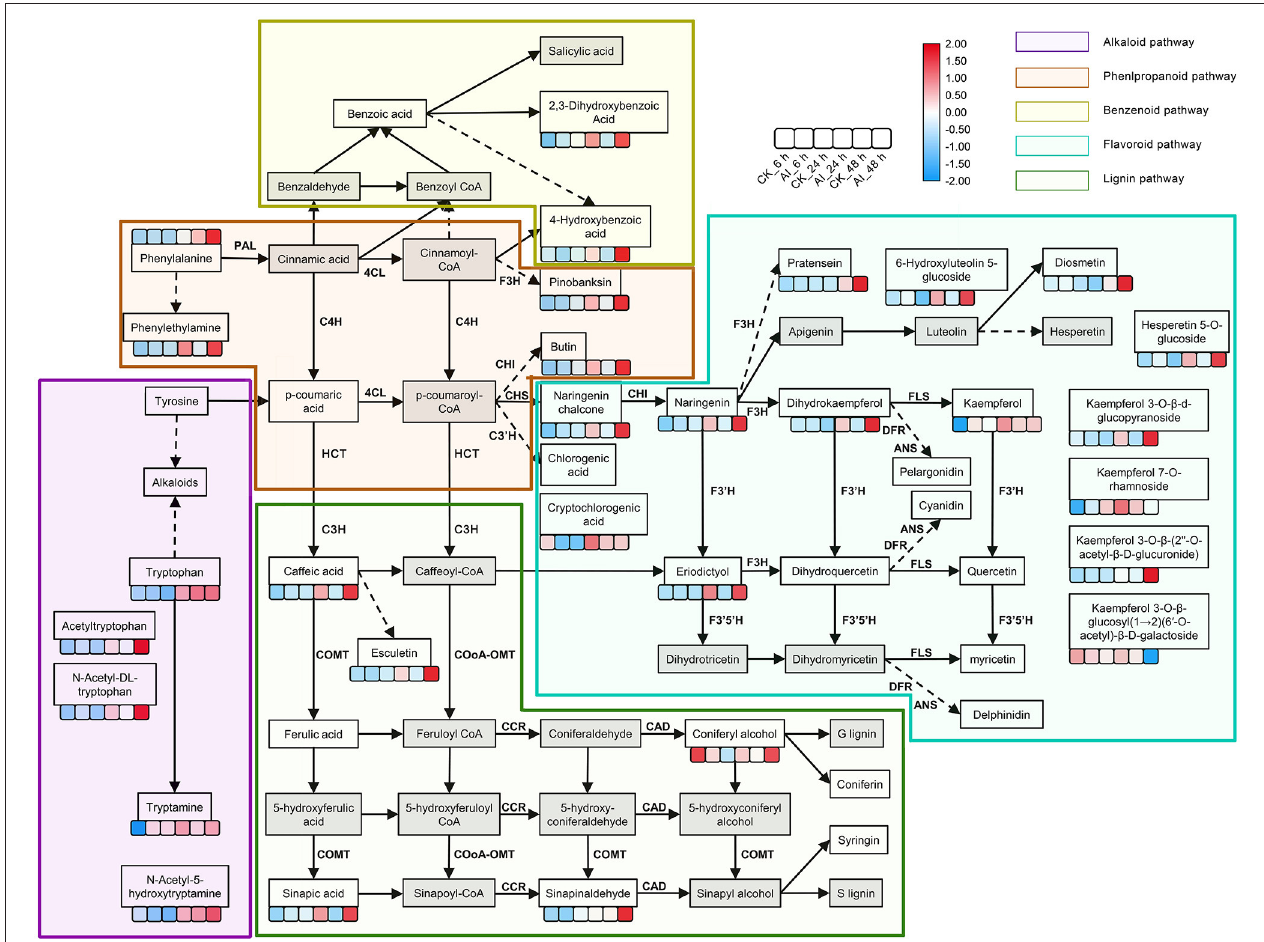
FIGURE 3 | Summary of metabolite changes in Lilium “Sorbonne” caused by B. elliptica infection. The metabolites not detected are indicated by a gray-filled grid. Dotted lines indicated some metabolites, and enzymes are not shown. Metabolites with statistically significant ( P ≤ 0.05) changes are shown in the heat map, in which blue and red colors indicate low and high accumulation, respectively. Data on the number of metabolites in the heat map were log-transformed. The six boxes represent control (uninoculated) and inoculated samples at different stages of infection (i.e., different time points post-inoculation): control_6h, inoculated_6h, control_24h, inoculated_24h, control_48h, and inoculated_48h (left to right). Different background colors represent different metabolic pathways: purple, alkaloid pathway; brown, phenylpropanoid pathway; yellow green, benzenoid pathway; blue, flavonoid pathway; green, lignin pathway. Gene names, annotations, and RNA-seq data are summarized in Supplementary Figure 15 . PAL, phenylalanine ammonia-lyase; C4H, cinnamic acid 4-hydroxylase; 4CL, p -coumaroylCoA ligase; HCT, hydroxycinnamoyl transferase; CSE, caffeoylshikimate esterase; C3 ′ H, coumaroylquinate 3 ′ -monooxygenase; COMT, caffeic acid O